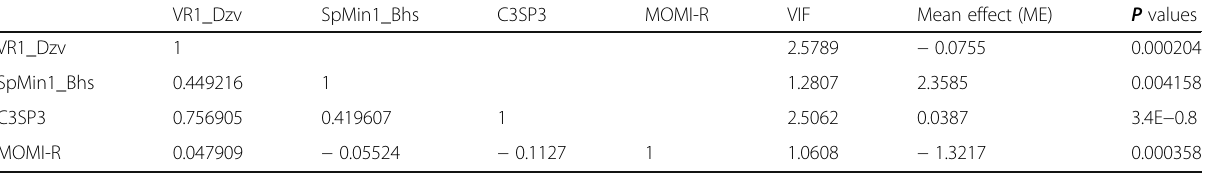
Table 7 Statistical analysis of the descriptors used in the QSAR model